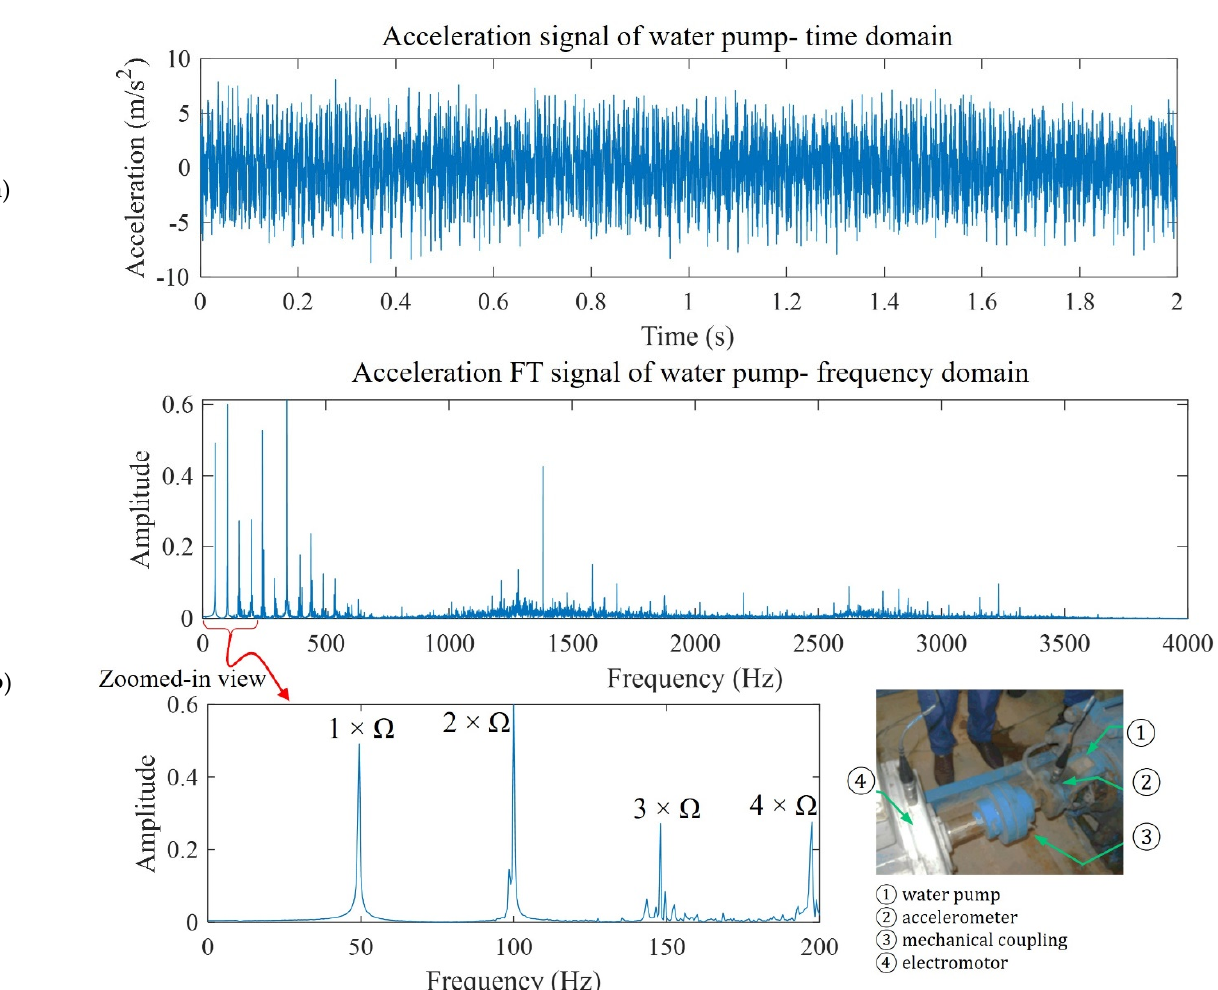
Figure 1. Real example of vibration from an operation machine: ( a ) acceleration and ( b ) frequency spectra of vibration signal from a water pump during operation.